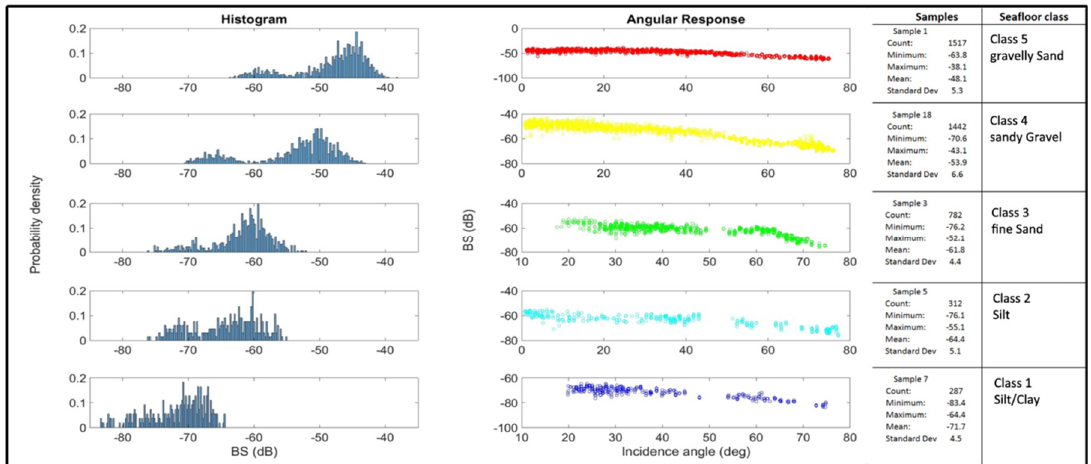
Figure 3. Descriptive statistics of soundings (belonging to each acoustic class) which were used for training of the random forest (RF) classifier along with the histogram and angular response of each training sample.